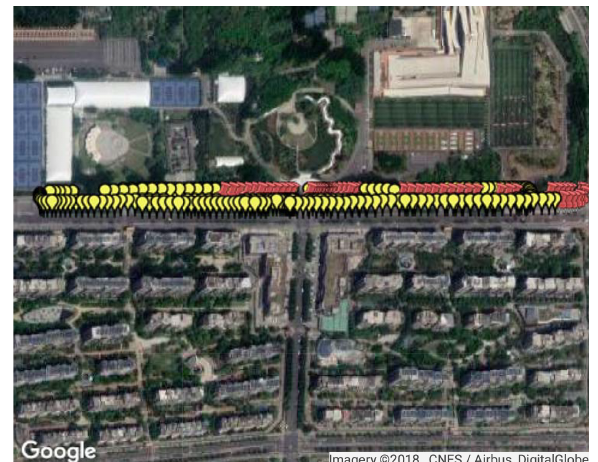
Figure 17. Illustration of points with and without manual satellite loss at Site 2. The red pushpins are points with satellite loss.